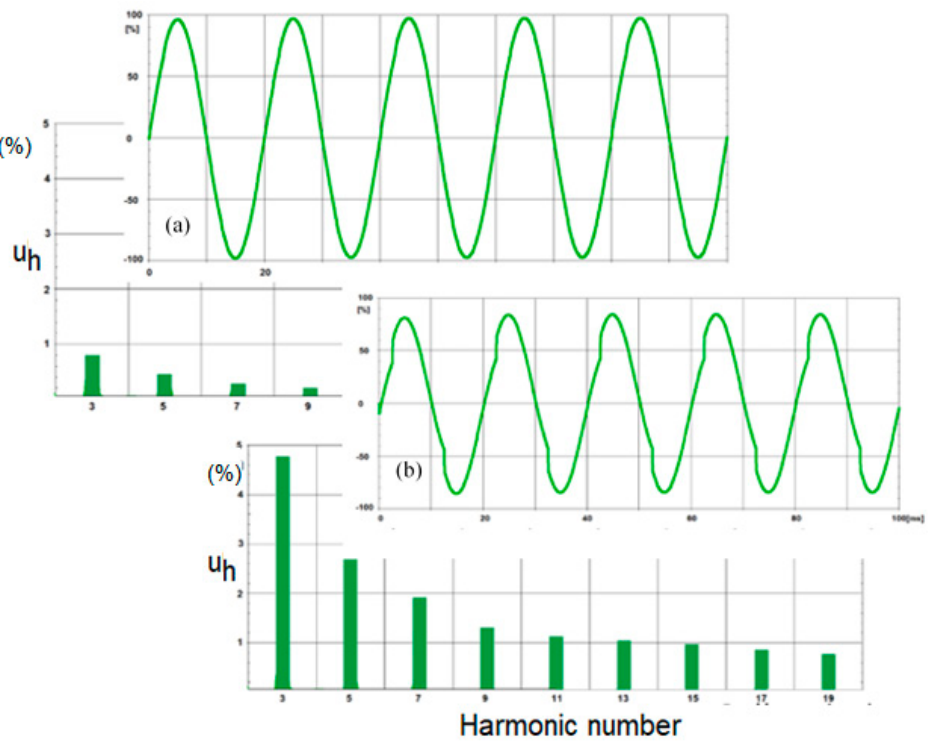
Figure 24. Waveforms and harmonics spectrum of the steel supply voltage for various short circuit power of the supply network at a rectangular arc voltage ( a ), change of voltage waveform and harmonics spectrum for S cc / S ctr = 140 ( b ), change of voltage waveform and harmonics spectrum for S cc / S ctr = 20 .